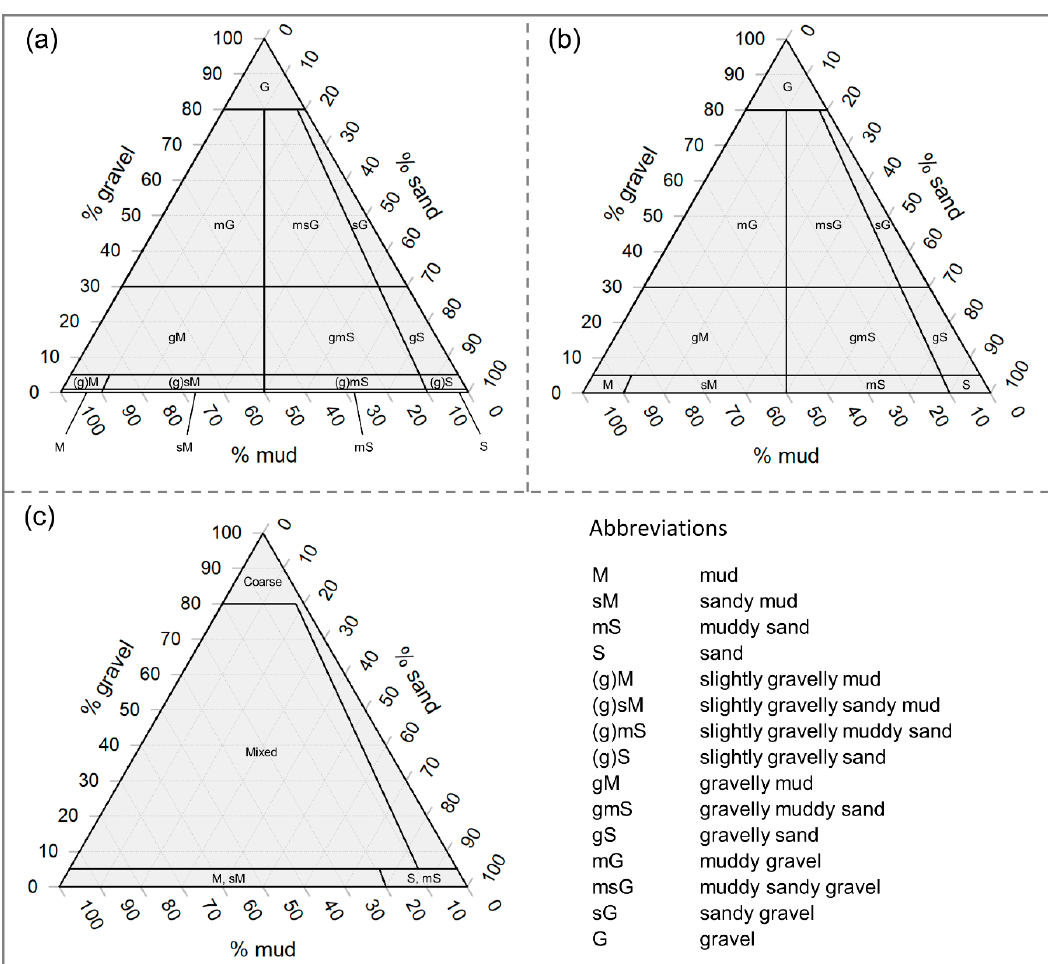
Figure 1. Ternary diagrams with ( a ) Folk, ( b ) simplified Folk and ( c ) European nature information system (EUNIS) classes.